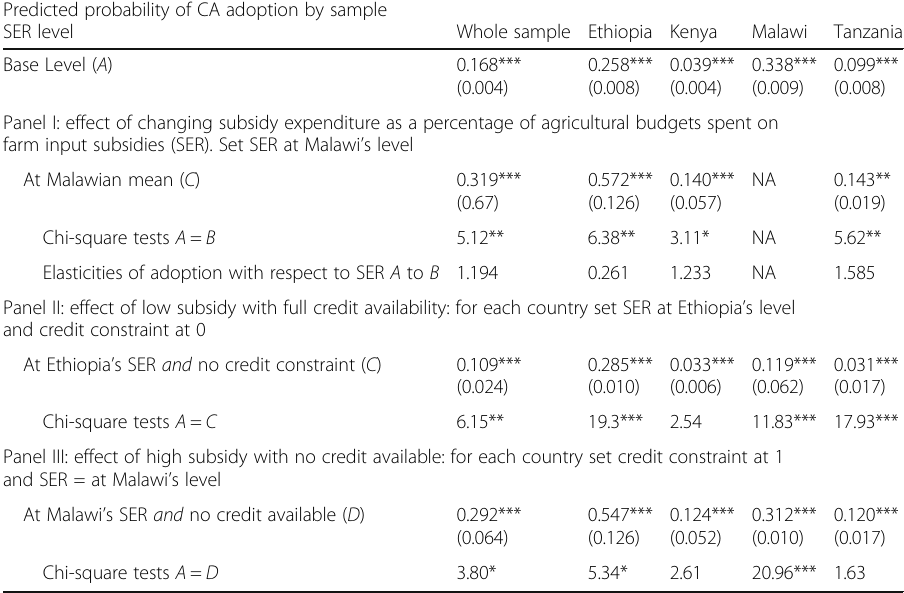
Table 5 Subsidy simulations Predicted probability of CA adoption by sample SER